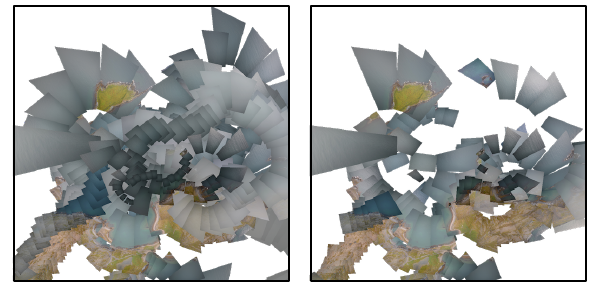
Figure 7: A crop from two image mosaics created using images from the same flight.